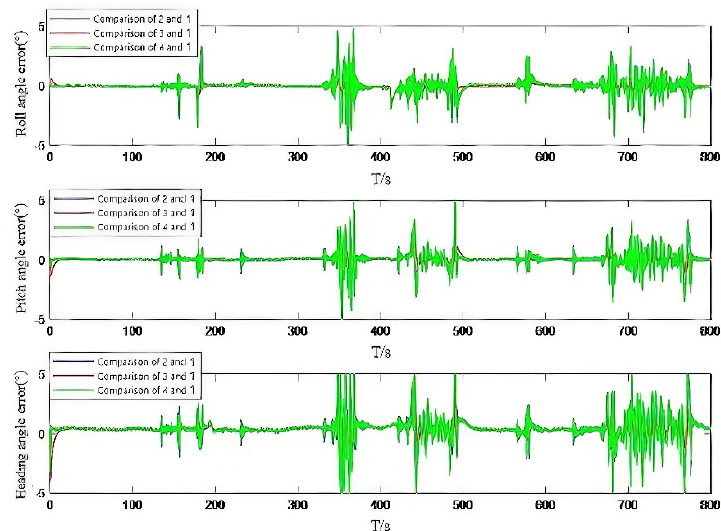
Figure 3. Accelerometer data and gyroscope data .